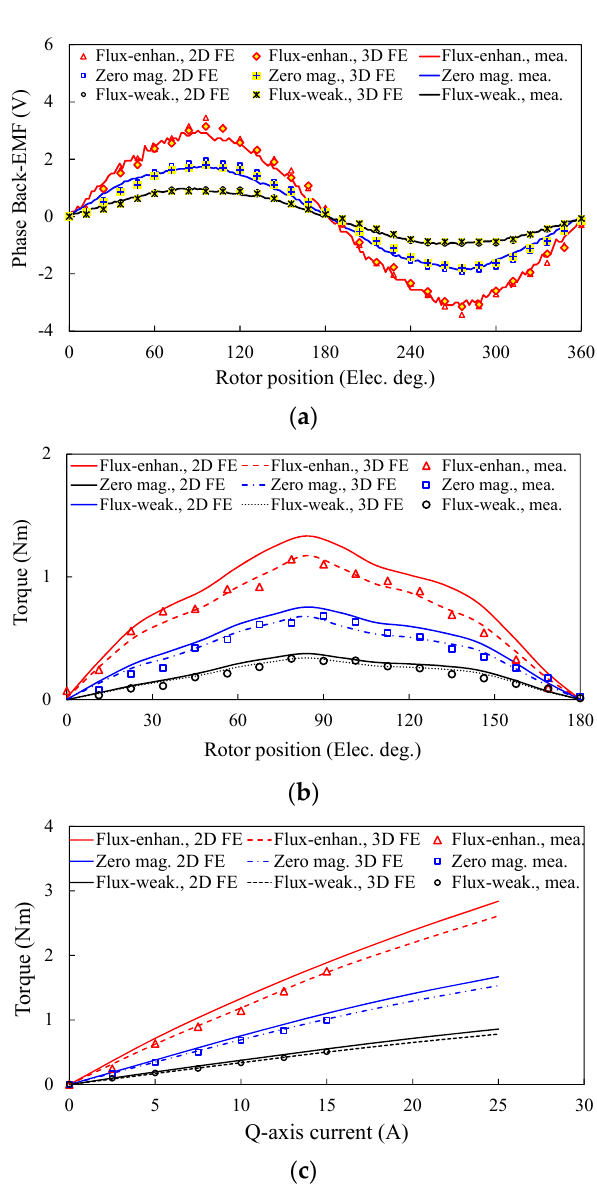
Figure 13. Comparison of finite element (FE)-predicted and measured results. ( a ) Back-EMF; ( b ) Static torque; ( c ) Torque against current characteristics. Table 3. Relative Errors between FE and Measured Results of PS-SF-HMMMs.